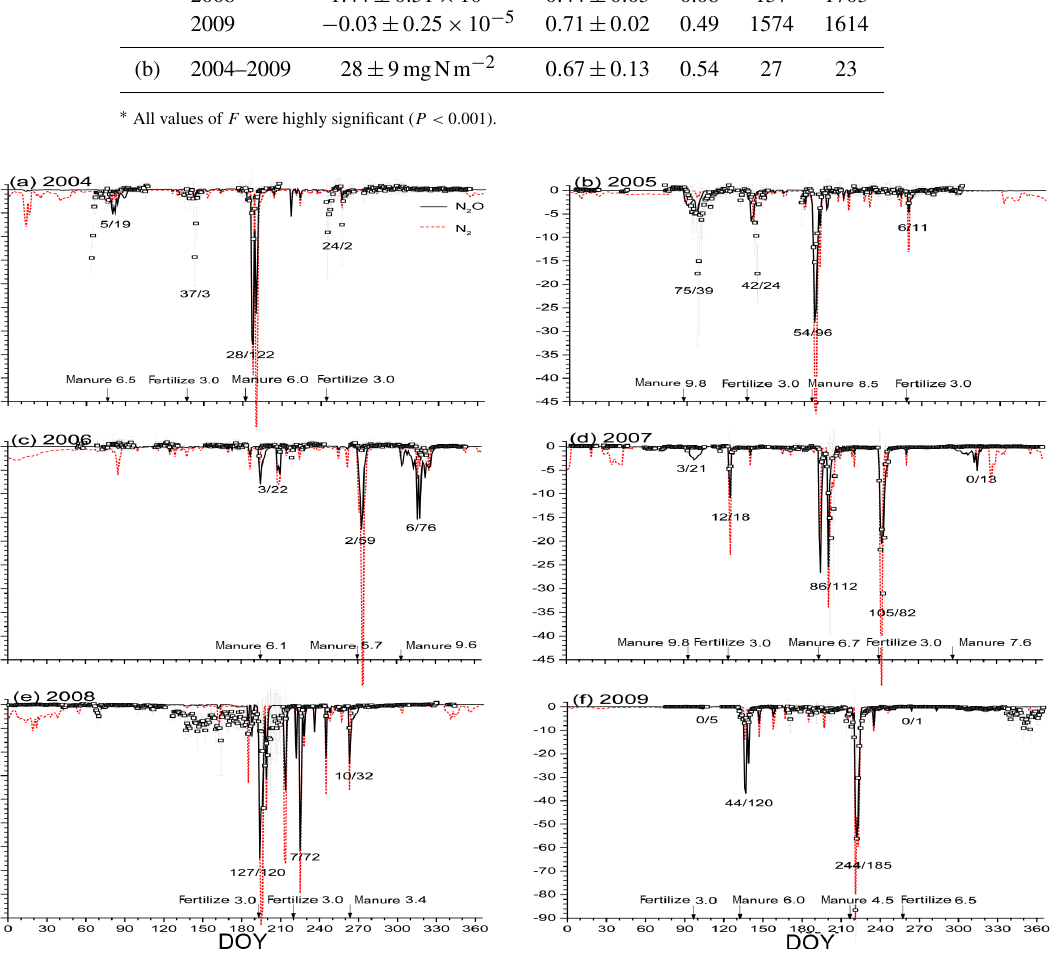
Figure 3. Daily aggregated N 2 O emissions measured (symbols) and N 2 O and N 2 emissions modelled (lines) from 2004 through 2009 at the Oensingen intensively managed grassland. Numbers above and beside each fertilizer or manure addition indicate total measured or modelled N 2 O-N emitted during emission events (mgNm − 2 ) and total N applied (gNm − 2 ). Negative values indicate effluxes to the